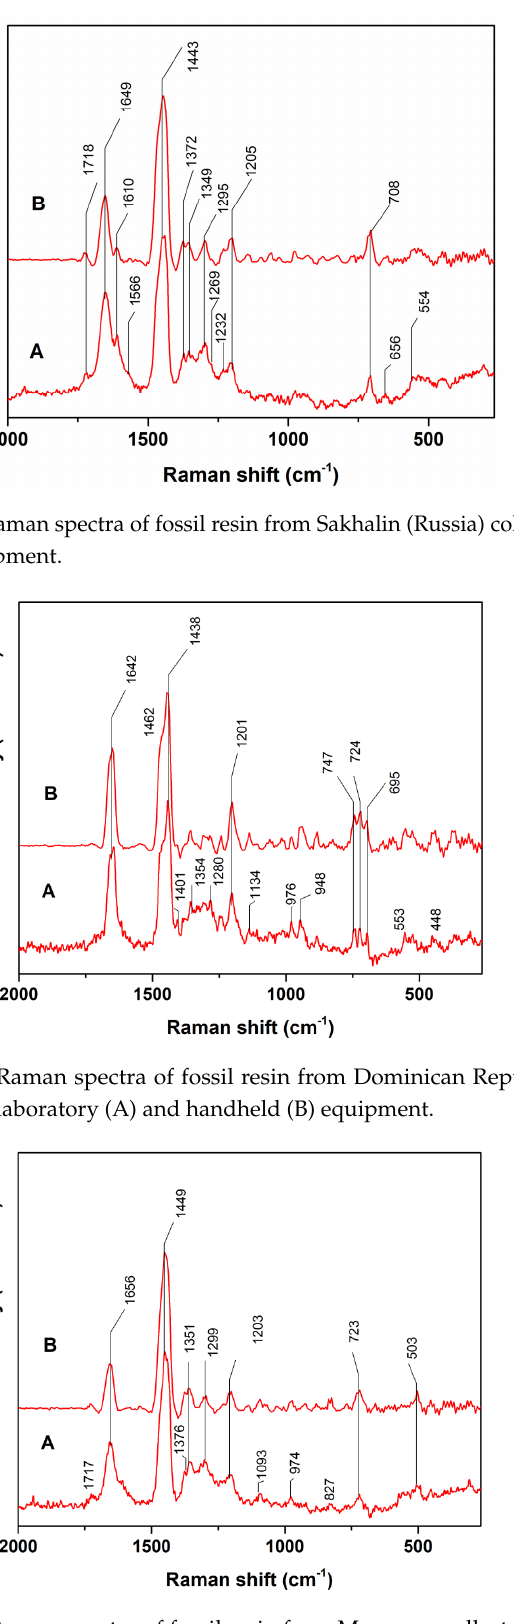
Figure 4. Comparison of Raman spectra of fossil resin from Myanmar collected with laboratory (A) and handheld (B) equipment.